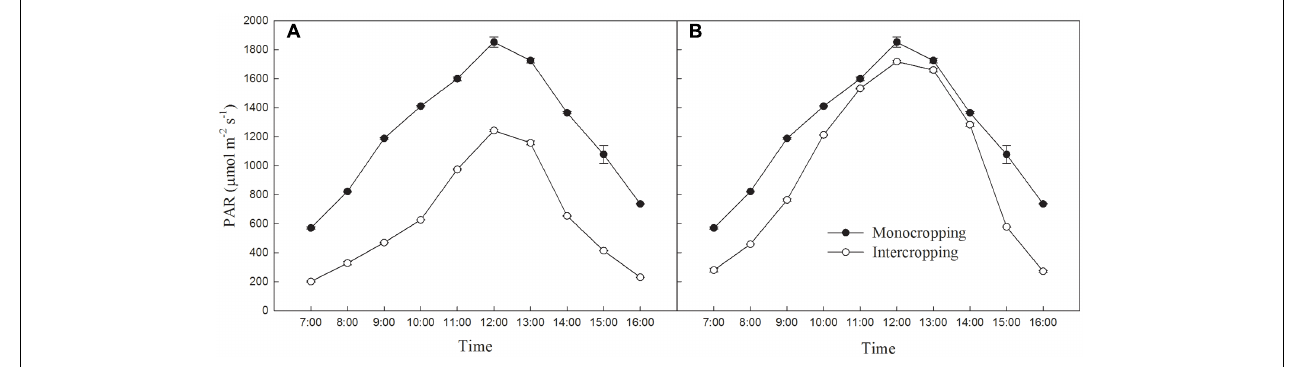
FIGURE 1 | (A) Diurnal variation of average PAR on the soybean canopy during July 25th, 2015 in Shenyang. (B) Diurnal variation of maximum PAR on the soybean leaf during July 25th, 2015 in Shenyang.